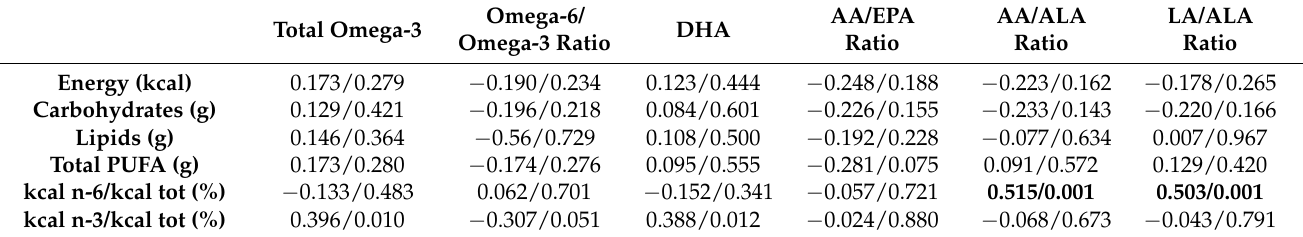
Table 5. Partial correlations (controlling for age) between PUFA levels and nutritional informa- tion ( n = 42, alpha = 0.006). Reported values are Pearson’s correlation index r/ p -value. In bold, significant correlations.